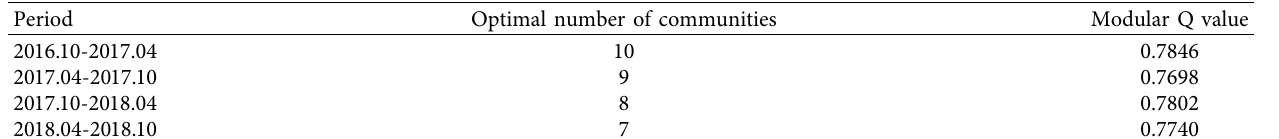
Table 7: Modular Q